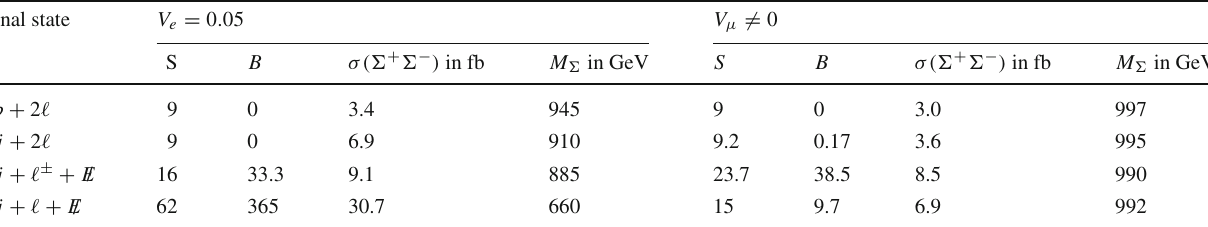
Table8 Themassreachat2TeVwithintegratedluminosityof300fb − 1 from selected channels of pair production of charged fermions, giving 3 σ sensitivity.Thecorrespondingproductioncrosssections σ((cid:2) + (cid:2) − ) ,